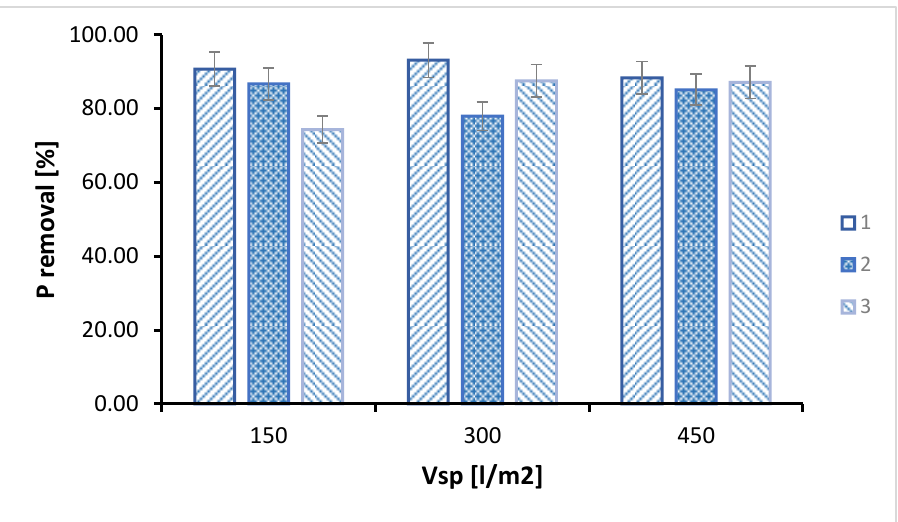
Figure 7. Representation of data variability of phosphorus removal rate for the applied HAOPs surface loading of 10 g/m 2 , with flux of 150 LMH, the abscissa indicates the specific volume ( V sp ) of permeate produced during filtration (the filtration was repeated 3 times, and the repetitions are marked as 1, 2 and 3).